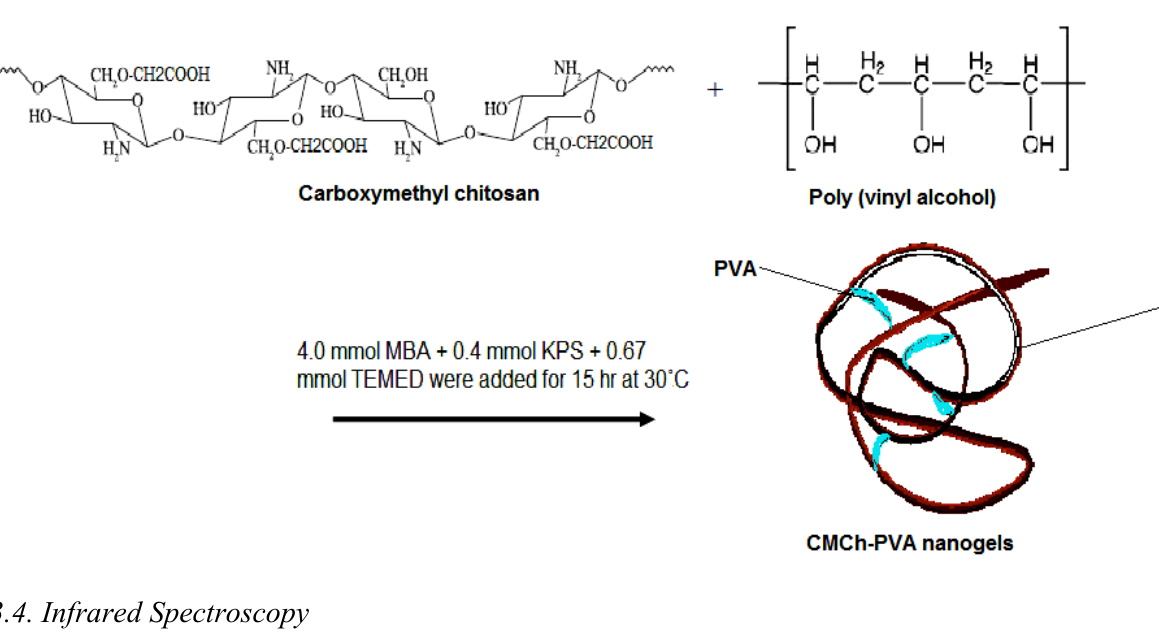
Figure 6. Schematic diagram of nanogels